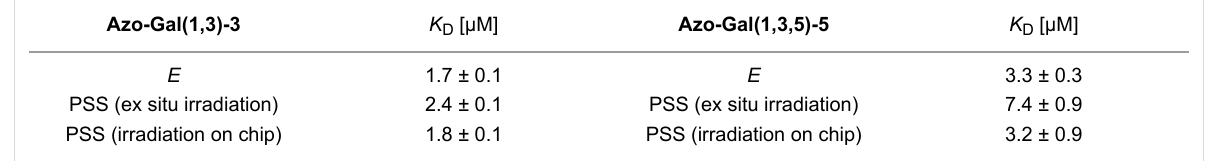
Table 3: K D values obtained by SPR direct binding assay of the photoswitchable glycooligomers (PSS: photostationary state @ 360